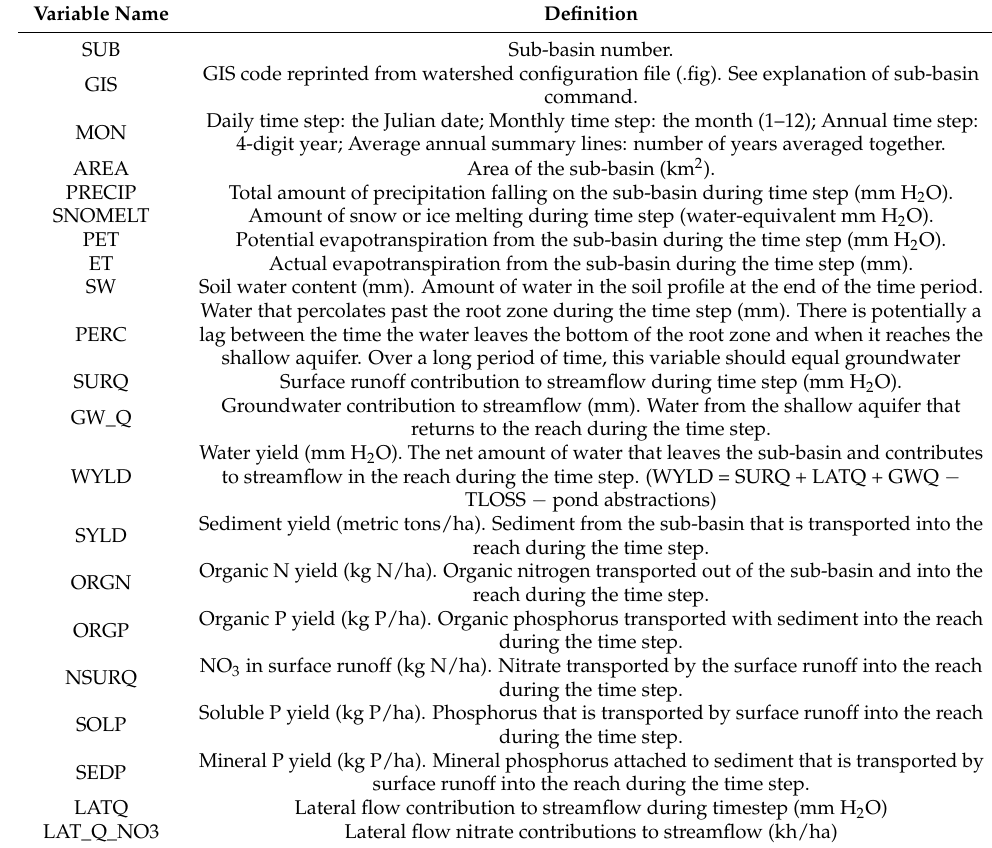
Table A2. Table defining variables used in output from the SWAT model for water quality and quantity indicators